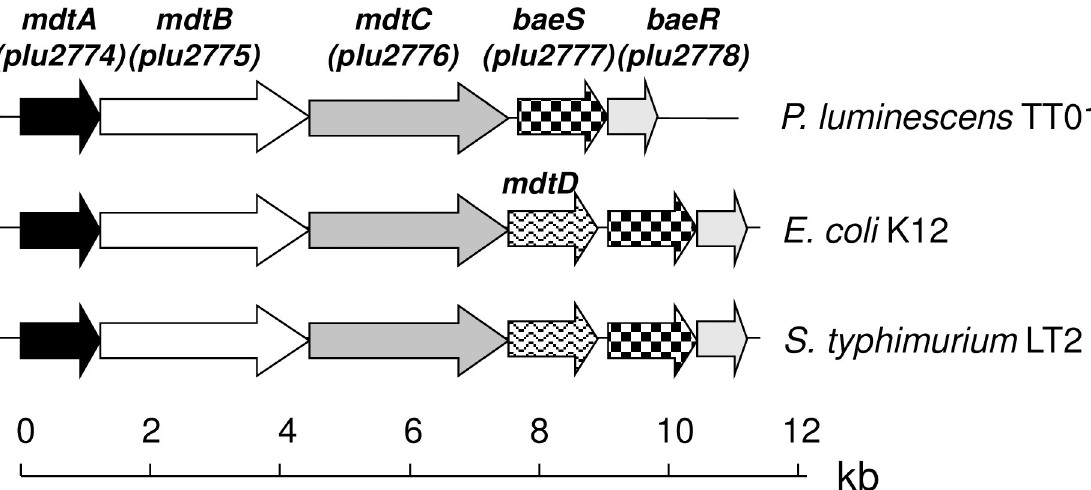
Fig 1. Genomic organisation of the mdtABC and baeSR loci in Photorhabdus luminescens TT01 and several enterobacteria. Photorhabdus luminescens TT01 (BX470251), Salmonella typhimurium LT2 (AE006468), and Escherichia coli K-12 (U00096). kb, kilobases.